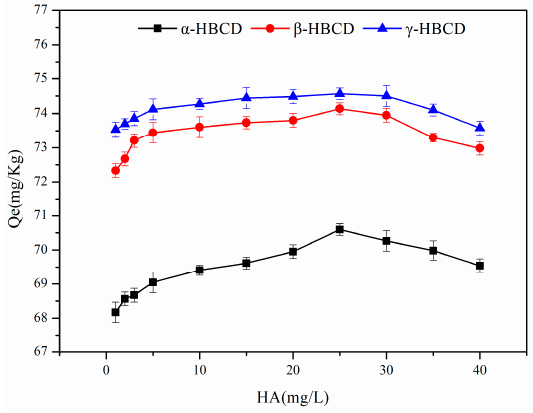
Figure 5. Effects of humic acid (HA) on HBCDs sorption in the sediment. Figure 5. E ff ects of humic acid (HA) on HBCDs sorption in the sediment.